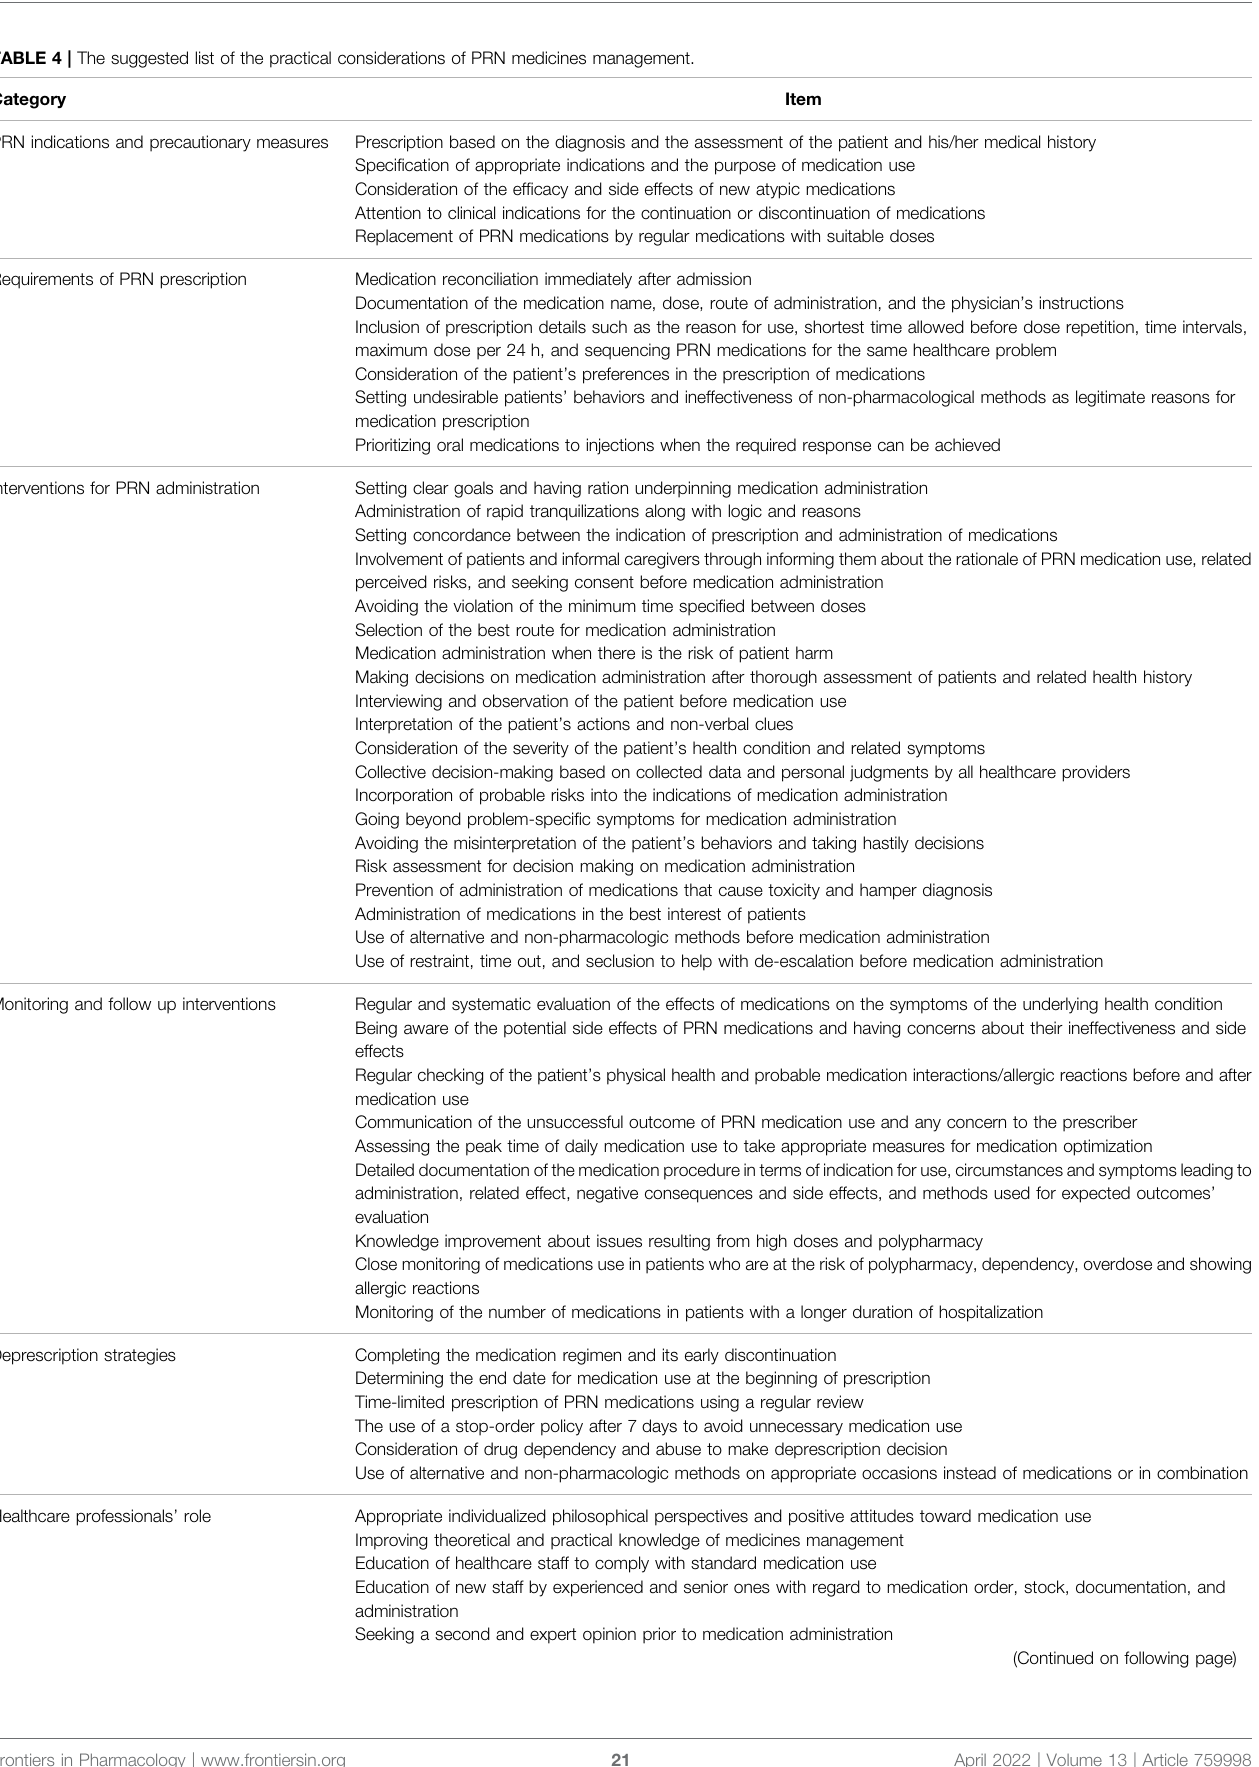
TABLE 4 | The suggested list of the practical considerations of PRN medicines